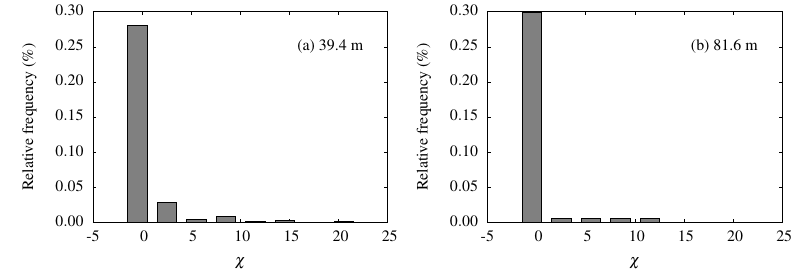
Figure 1. Histograms of χ (see Eq. 3) at (a) 39.4 and (b)